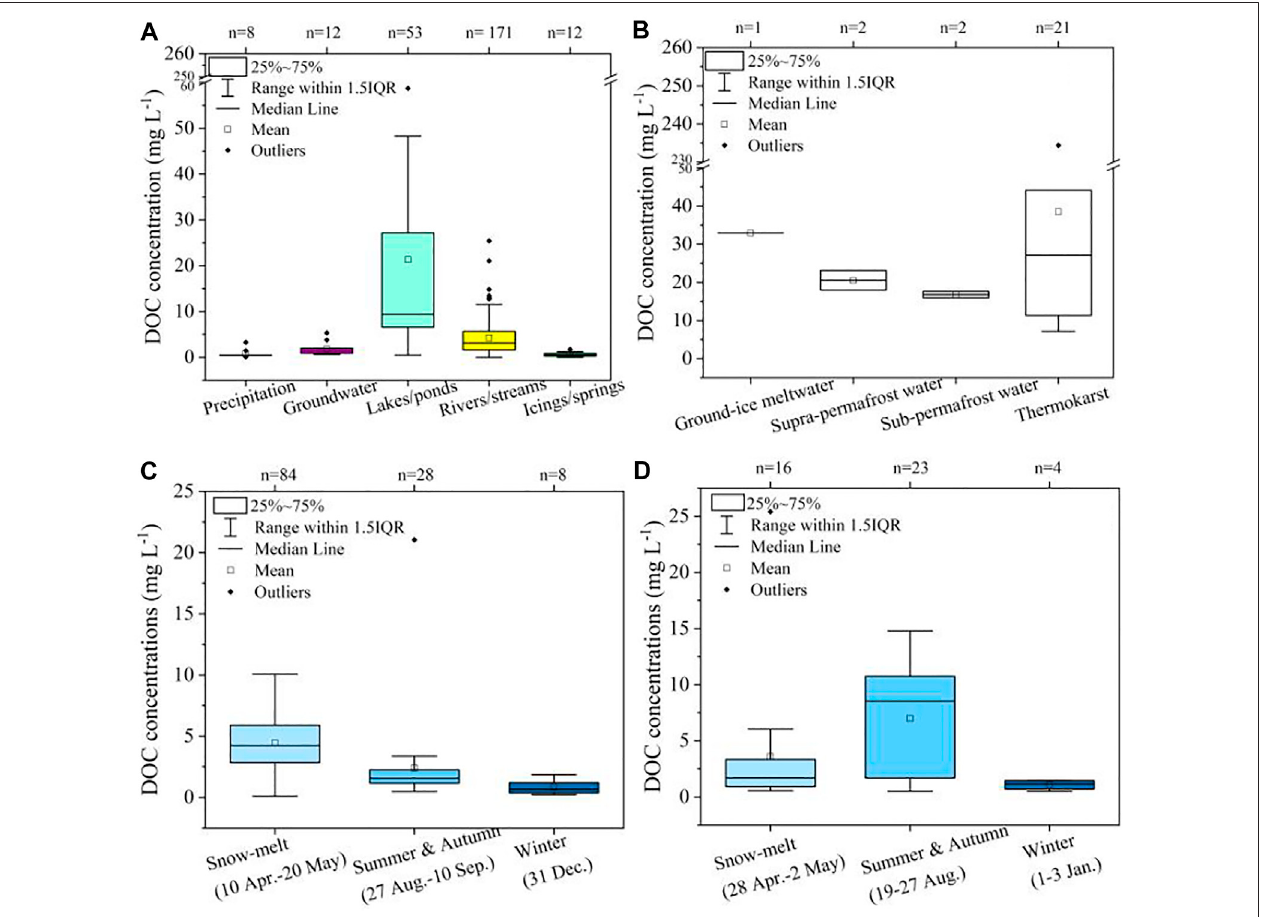
FIGURE 2 | Dissolved organic carbon concentrations (mg C · L − 1 ) in aquatic systems in the source area of the Yellow River (SAYR) above the Tanag hydrological station in Qinghai Province, SW China. Notes: “ n ” indicates the number of fi eld samples. (A) DOC concentrations in individual water type (hail/snow/rain, groundwater, lakes/ponds, river/stream, and icing/spring); (B) permafrost-related aquatic DOC concentrations; (C) seasonal variations of in-stream DOC concentrations in 2016; (D) seasonal variations of in-stream DOC concentrations in 2017.